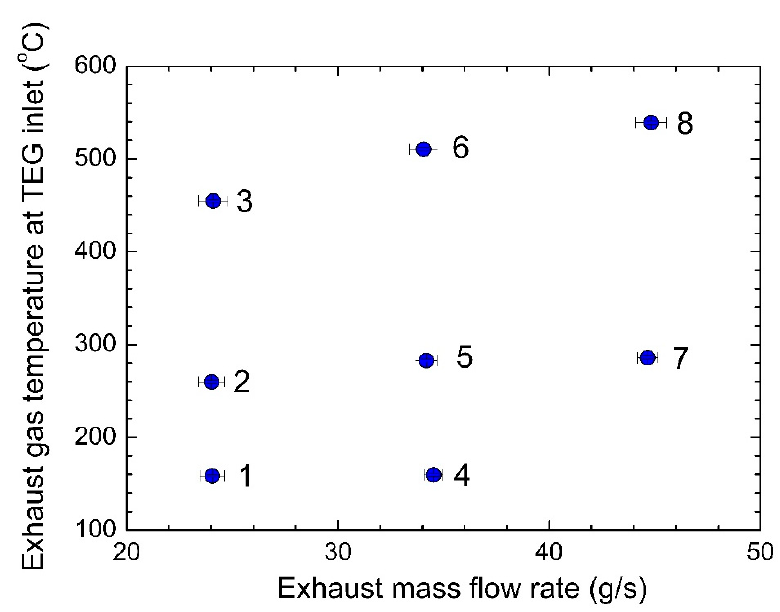
Figure 3. Exhaust gas temperature at ATEG inlet as a function of the exhaust mass flow rate for the eight experimental points analyzed.